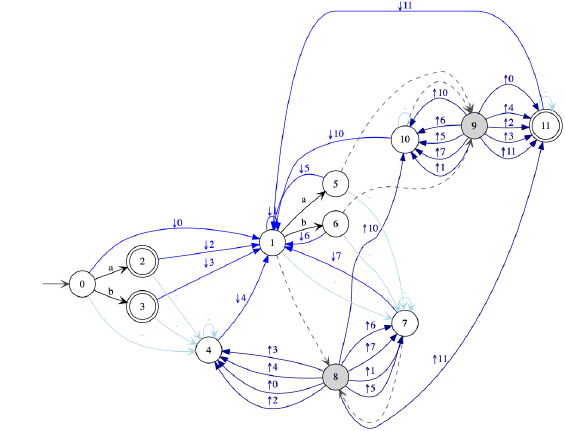
Figure 20. Deterministic NWA : nwa ( det ( step ( ch ∗ ( a + b ))))